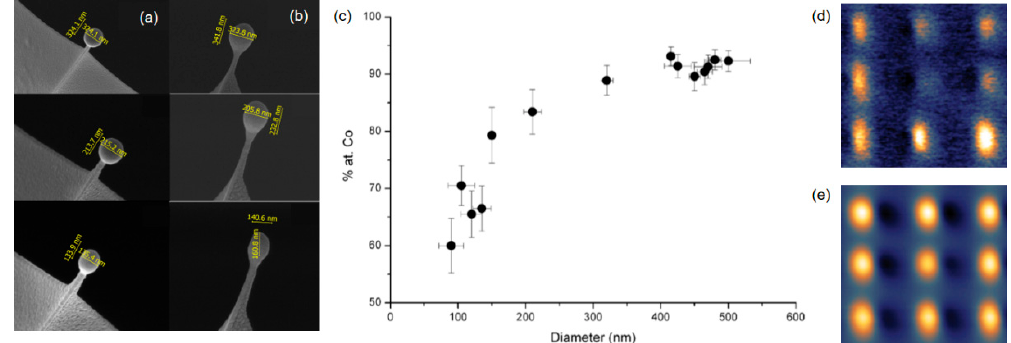
Figure 9. FEBID-based ferromagnetic resonance force microscopy (FMRFM). ( a ) and ( b ) show differently sized Co nano-spheres (top down), fabricated on top of a high-resolution AFM cantilever in the top ( a ) and side views ( b ), revealing a close to spherical morphology. ( c ) shows the cobalt content of the beads as a function of the diameter, which has to be correlated with its magnetic properties. Additional measurements revealed a minimum diameter of 150 nm to exploit the full performance. ( d ) and ( e ) show FMRFM and MFM measurements, respectively, using a Co-AFM cantilever modified via FEBID. These measurements use an in-plane magnetic field, which aligns the sample magnetization. A microwave-frequency current is then introduced perpendicular to the magnetic field, but also in-plane. The latter decreases the quasi-static component of the magnetization, which impacts the magneto-static force between the sample and tip. Once the magnetic resonance is found, FMRFM reveals defects induced by chemistry or morphology, as provoked in this example by a different shape of the central element in the 3 × 3 array. This explains why that part is dark in FMRFM mode ( d ). In contrast, classical MFM measurements are unable to detect such defects, as shown in ( e ). Although powerful in its analytical capabilities, the lateral resolution is currently limited to about 90 nm, as that depends on the bead diameter. ( a – c ) were adapted and reprinted from Sangiao et al., Beilstein J. Nanotechnol. 2017 [117]. ( d ) and ( e ) were adapted and reprinted from Chia et al., Appl. Phys. Lett. 2012 [118].